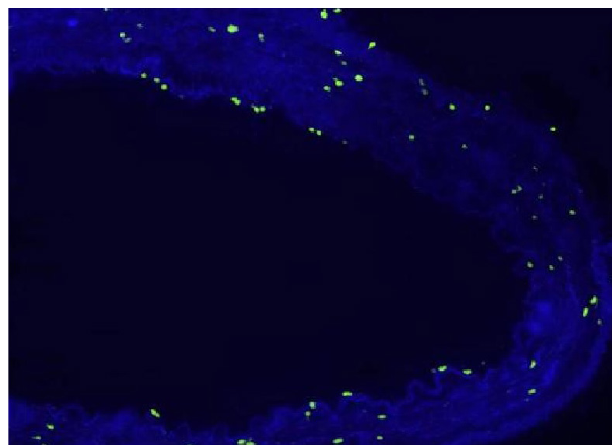
Fig. 2C – Terminal deoxynucleotidyl transferase-mediated dUTP-biotin nick end labeling (TUNEL) stain of an artery in the nitroprusside group (Group N).